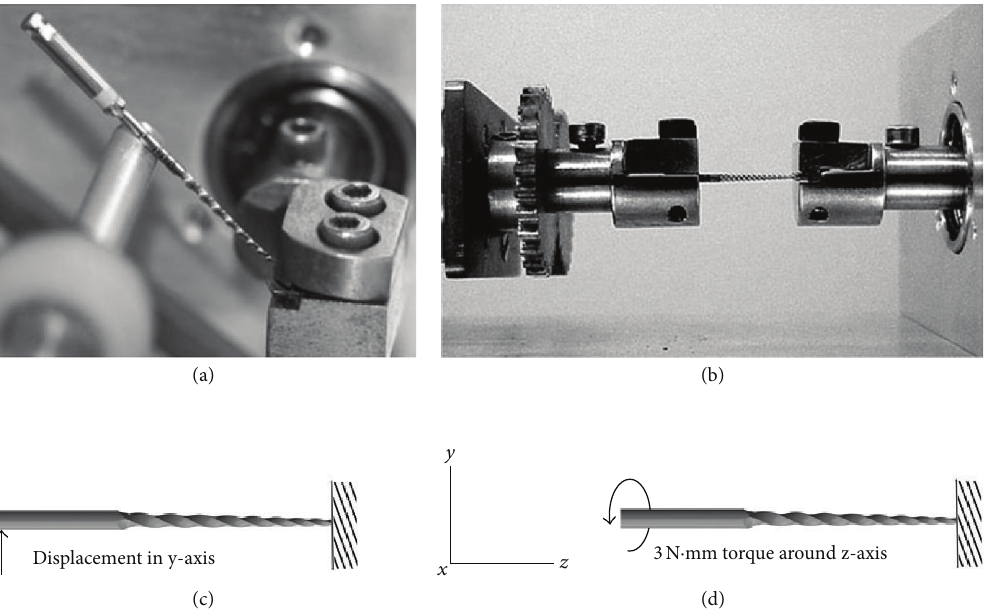
Figure 3: Experimental tests and respective load and boundary conditions: (a) experimental bending test, (b) experimental torsional test, (c) simulated bending test, and (d) simulated torsional test.